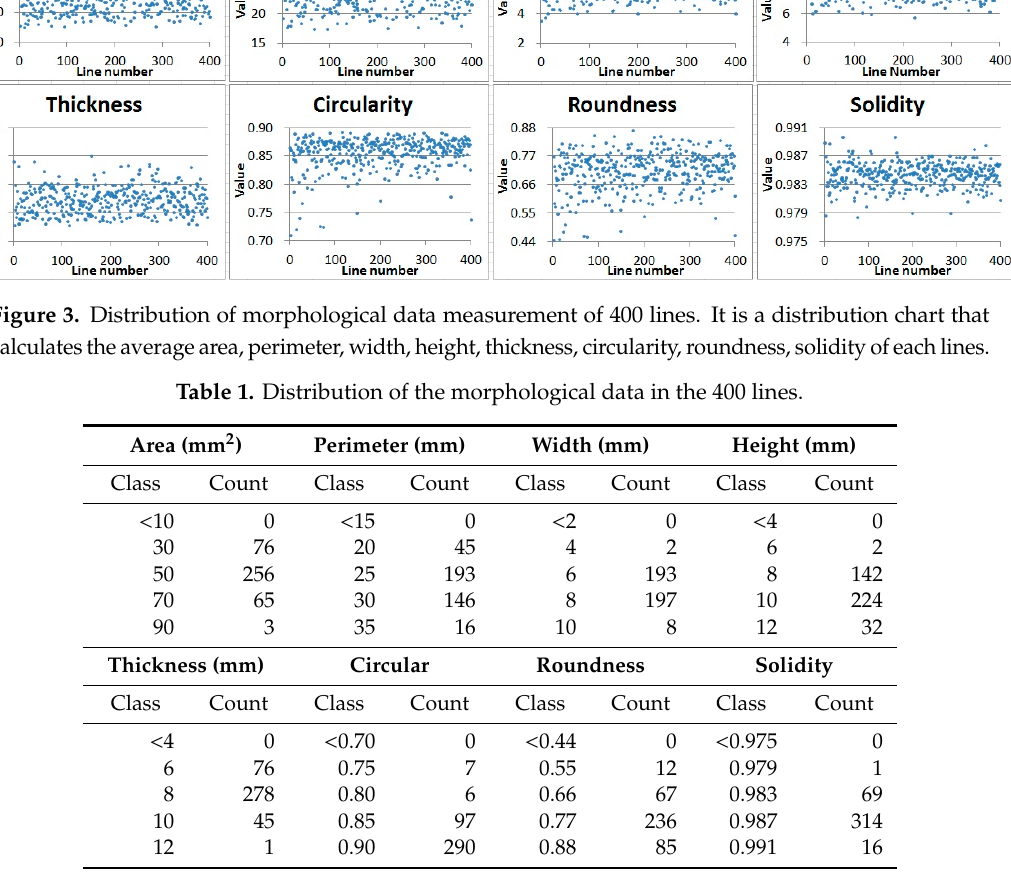
Table 1. Distribution of the morphological data in the 400 lines.